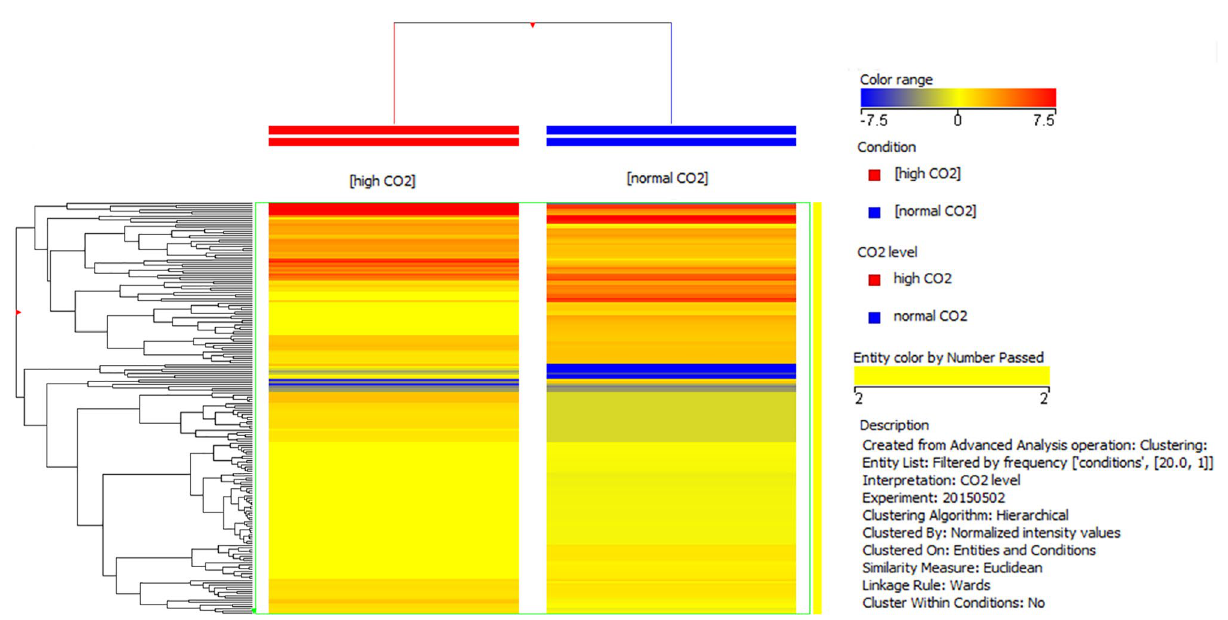
Figure 3. Hierarchical clustering of all proteins identified in the normal p CO 2 and in the high p CO 2